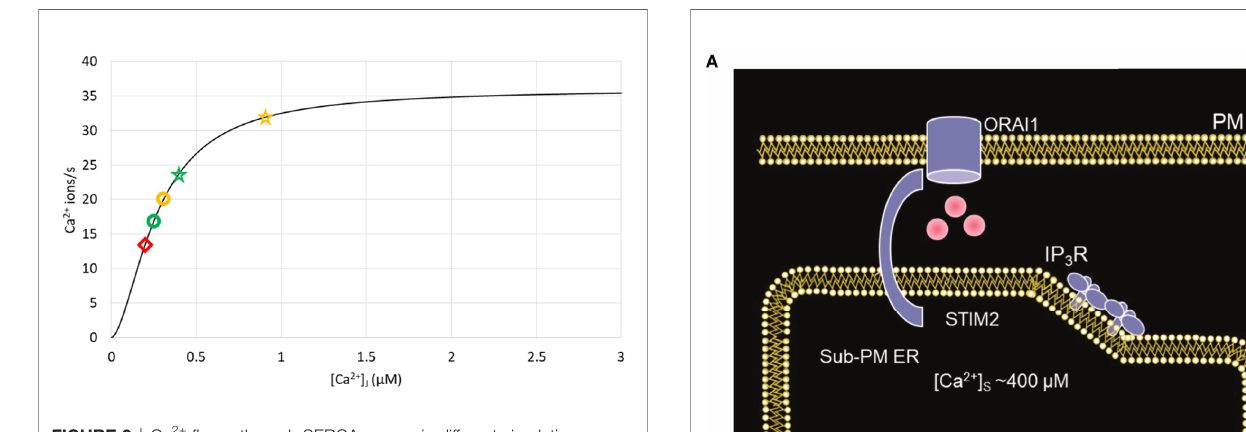
b 1-integrins, IP 3 signaling, and ORAI activation via pre-formed complexes with STIM1 and STIM2 (15). Weak adhesion of T